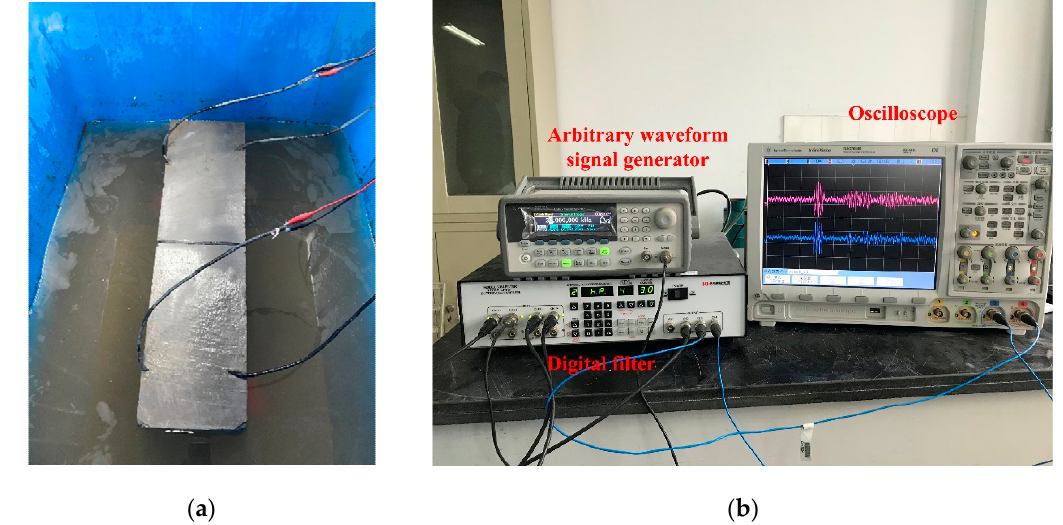
Figure 9. Experimental setup for underwater crack detection: ( a ) the specimen immersed in water; ( b ) experimental devices and the connections.